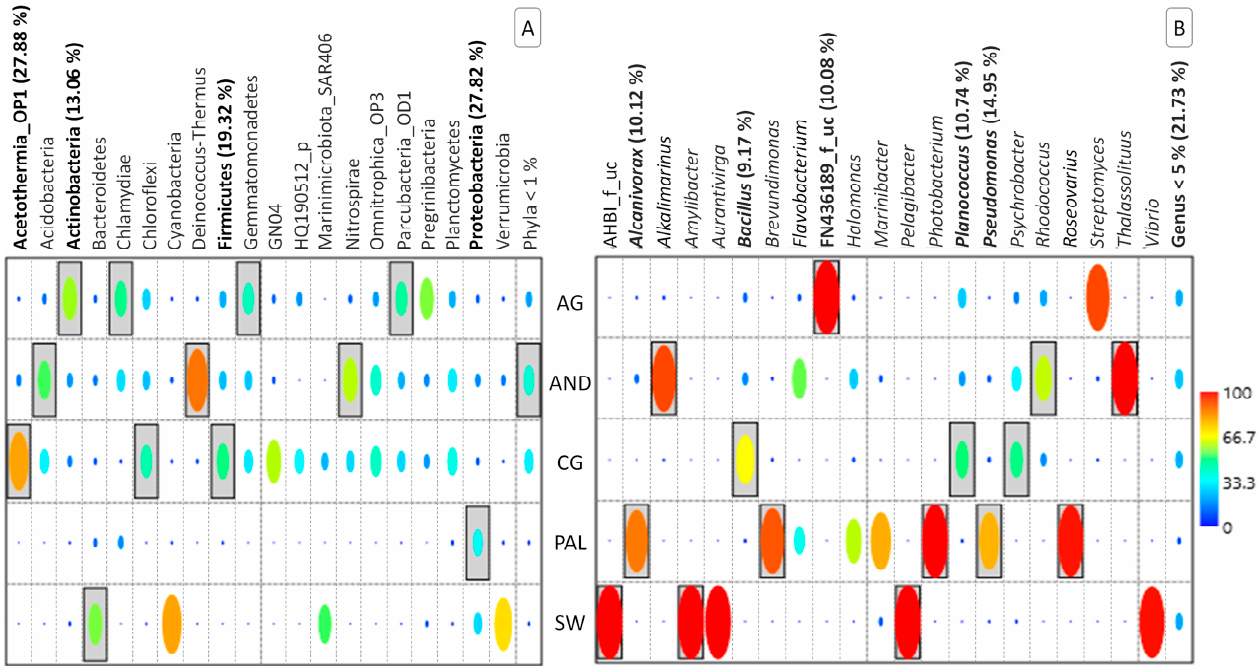
Figure 4. Species indicator analysis at the taxonomic levels of Phylum ( A ) and Genus ( B ). Statistically significant taxonomic groups are boxed, while the names of those that, according to SIMPER analysis, contributed most to establishing the overall differences between aquifers, are highlighted in bold. The percentage contribution explaining the observed differences in each case is included in parentheses.